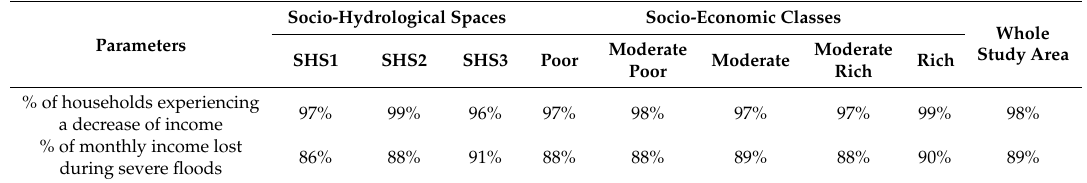
Table 3. Decrease of income due to floods in the study area.